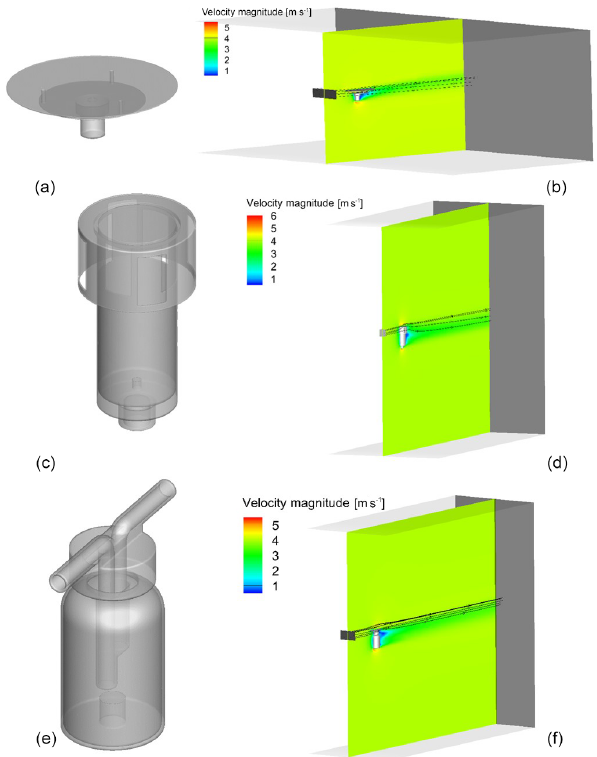
Figure 3. Geometries of the flat-plate sampler (a, b) , Sigma-2 sam- pler (c, d) and MWAC sampler (e, f) . CFD modeling domain and velocity magnitude, inlet velocity: 4ms − 1 (b, d, f) ; in addition, the injection area is shown in black (flat-plate sampler: width 0.2m, height 0.05m; Sigma-2 sampler: width 0.2m, height 0.1m; bottle sampler: width 0.1m, height 0.05m), along with exemplary stream